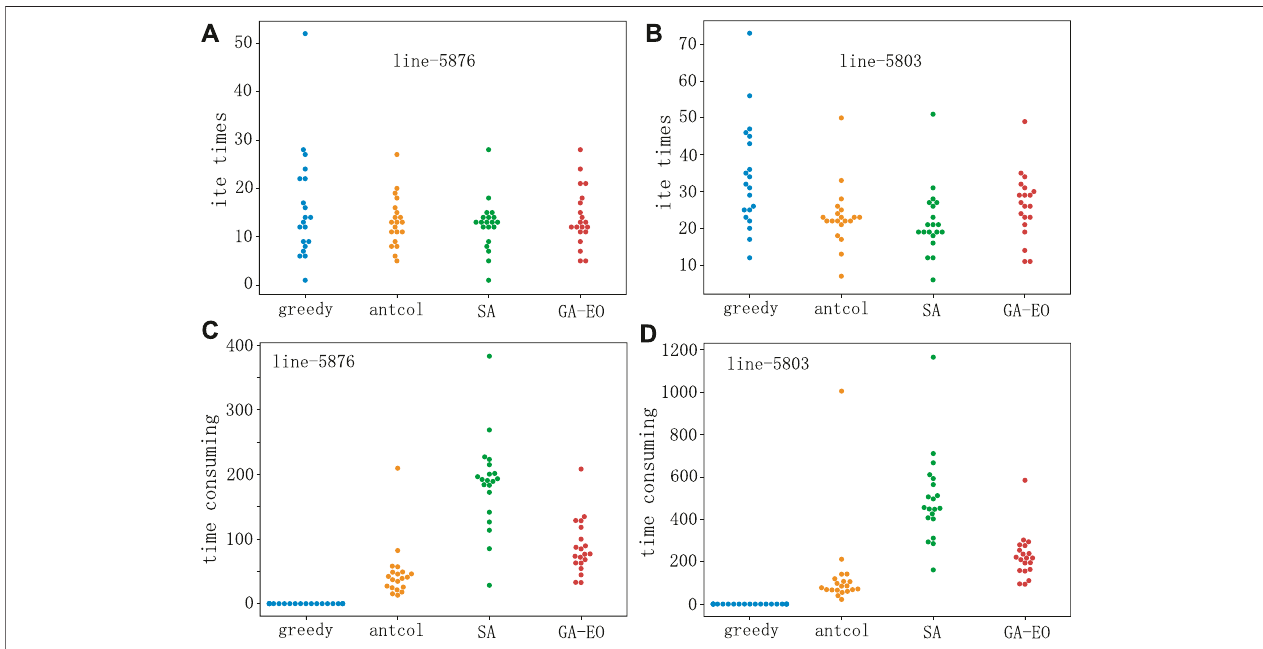
FIGURE 9 | (color online) (A,B) Number of iterations converging to the optimal solution with our framework under the four algorithms. The results are obtained by 20 independent simulations. (C,D) Time-consuming (seconds) of converging to the optimal solution with our framework under the four algorithms.